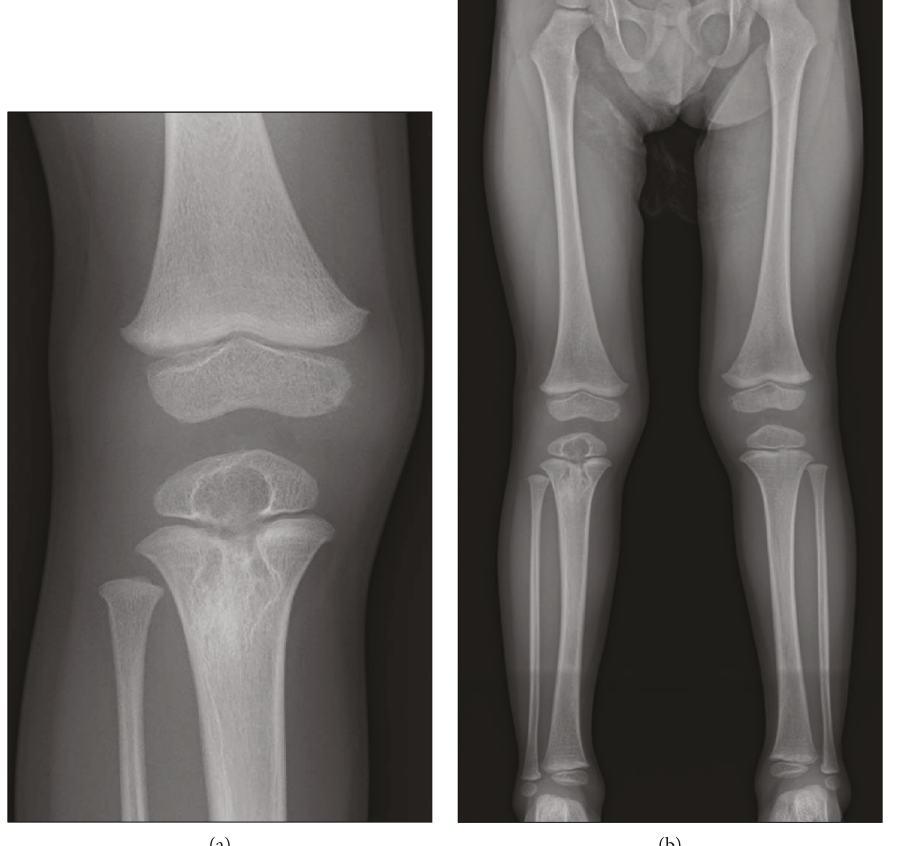
Figure 6: Eight months postoperatively. (a) Plain radiograph showing bone regeneration in the area of curettage and a slight physeal bridge at the right proximal tibia. (b) Growth disturbance and deformation were not seen in a full-length lower-limb